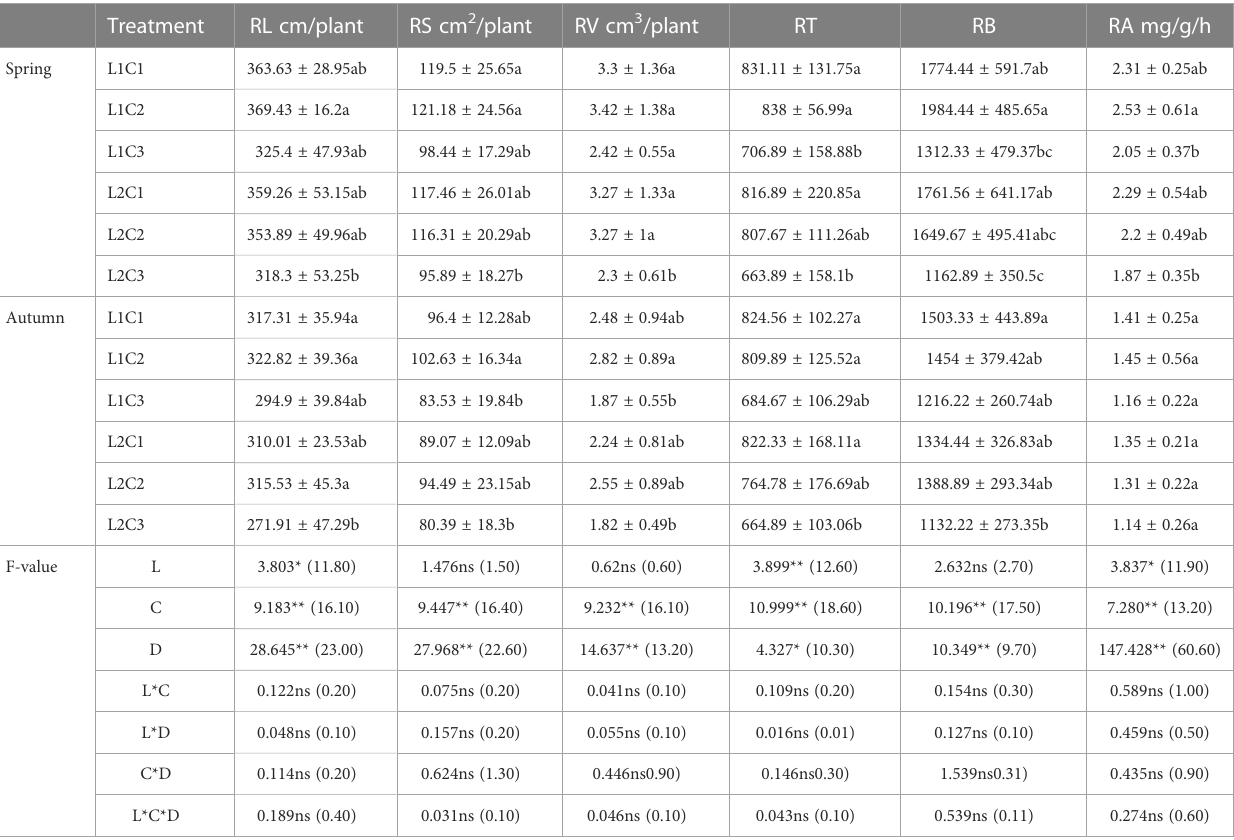
TABLE 5 Root morphology of tomato in